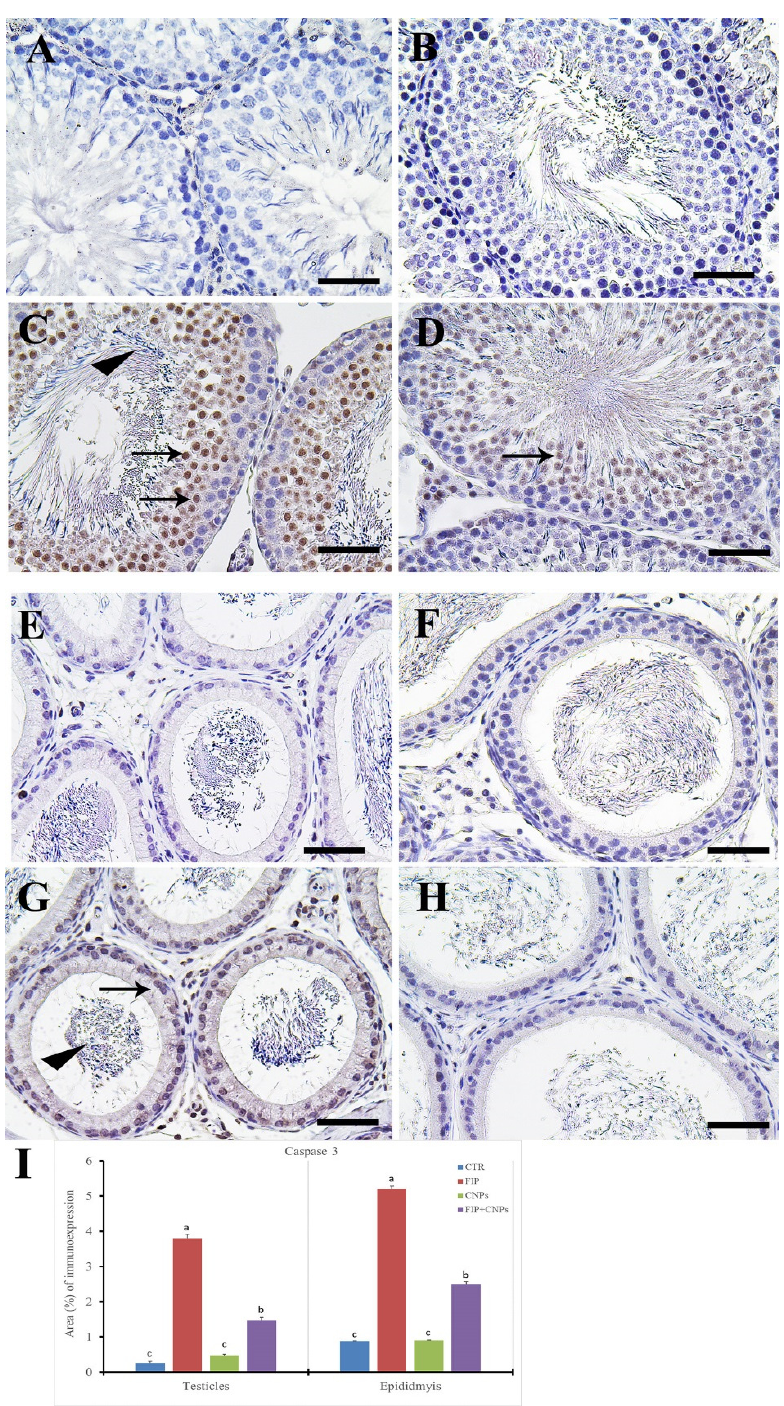
Figure 3. Immunohistochemical staining of rat testis Casp3. ( A ) Control group. ( B ) CeNPs group. ( C ) FIP group revealed strong Casp3 reaction in the nuclei of primary and seconadry spermatocytes (arrows), while all sperms have negative reaction (arrowhead). ( D ) FIP supplemented with CeNPs revealed very weak Casp3 reaction (arrow). ( E ) Epididymal of control group. ( F ) CeNPs group. ( G ) FIP group showed strong positive Casp3 reaction in the nuclei of principal epididymal cells (arrow) and nearly negative reaction in the sperms (arrowhead). ( H ) FIP treated with CeNPs. ( I ) Semi-quantification of Casp3 in the testicular and epididymal tissues in different groups of rats. Scale bar = 50 µm. Data expressed as mean ± SE and analyzed using one-way ANOVA at p ≤ 0.05. FIP+CeNPs group revealed nearly negative Casp3 reaction in the epididymal tubules (Figure